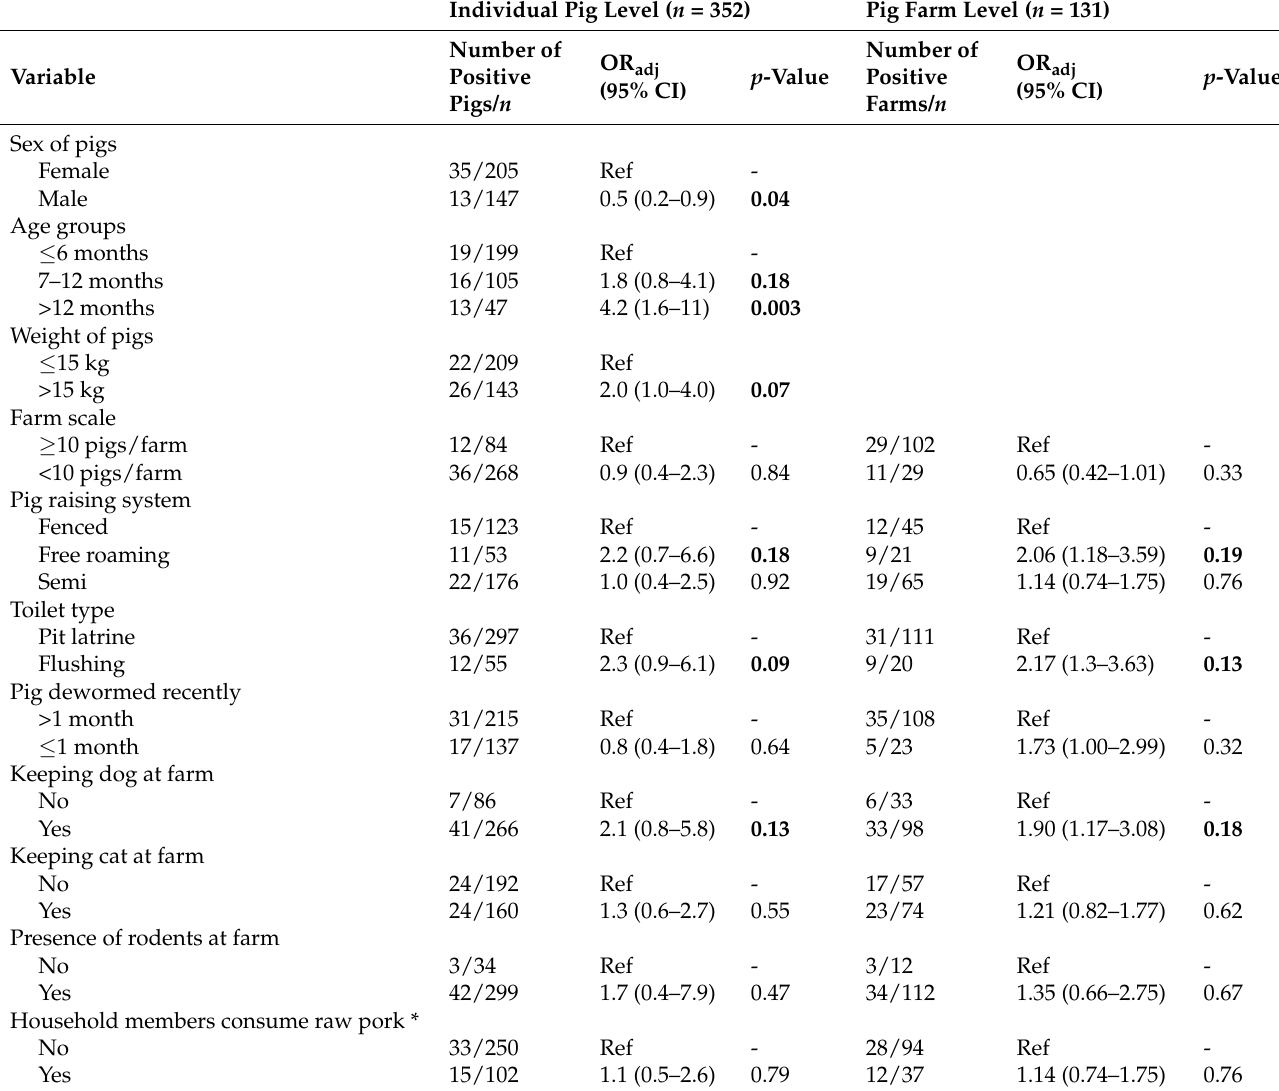
Table 3. Univariate GLMM results at individual pig- and farm-levels related to Trichinella spp. seropositivity in Da Bac district, Hoa Binh province,